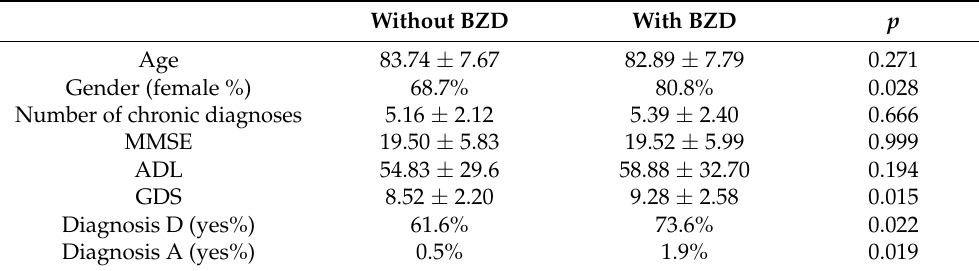
Table 2. Comparison of characteristics of depressive NH residents with and without benzodiazepine (BZD) treatment ( n = 317, means ± SD; or %).